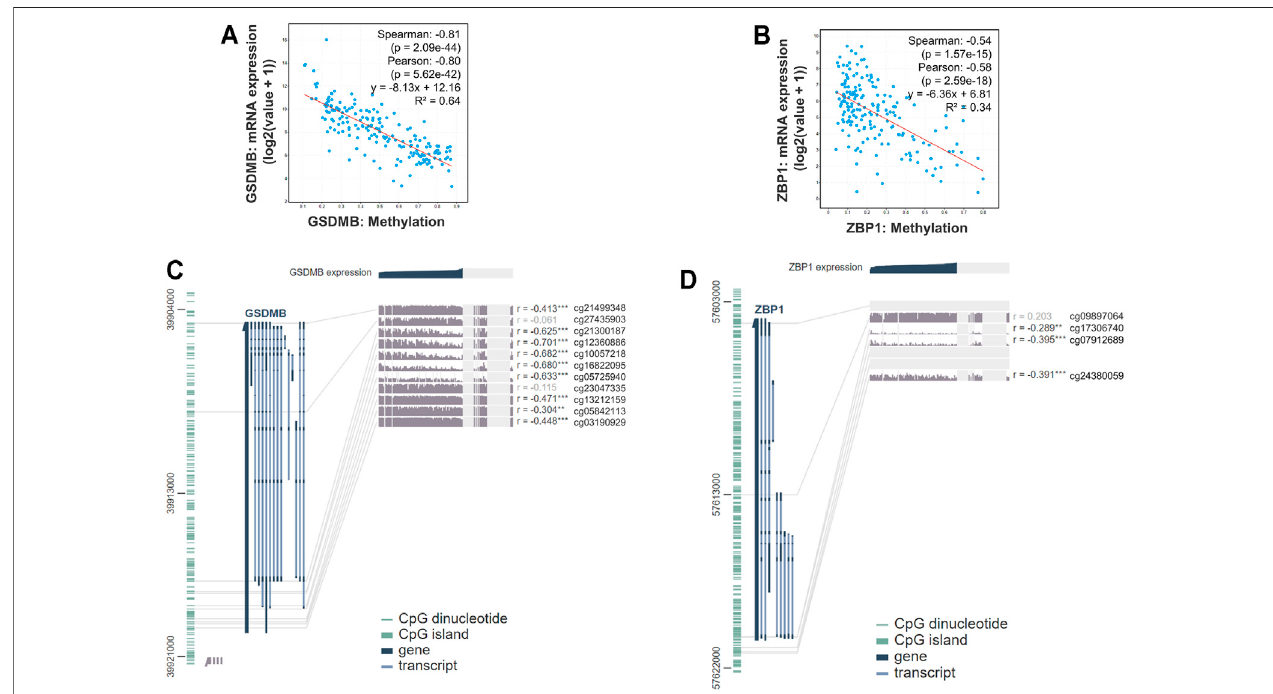
FIGURE 6 | Gene expression and methylation status in EAC. The correlation between GSDMB (A) and ZBP1 (B) methylation with RNA expressions by analysis using the cBioPortal database. Detailed information on methylated probes of GSDMB (C) and ZBP1 (D) by analysis using the MEXPRESS database.